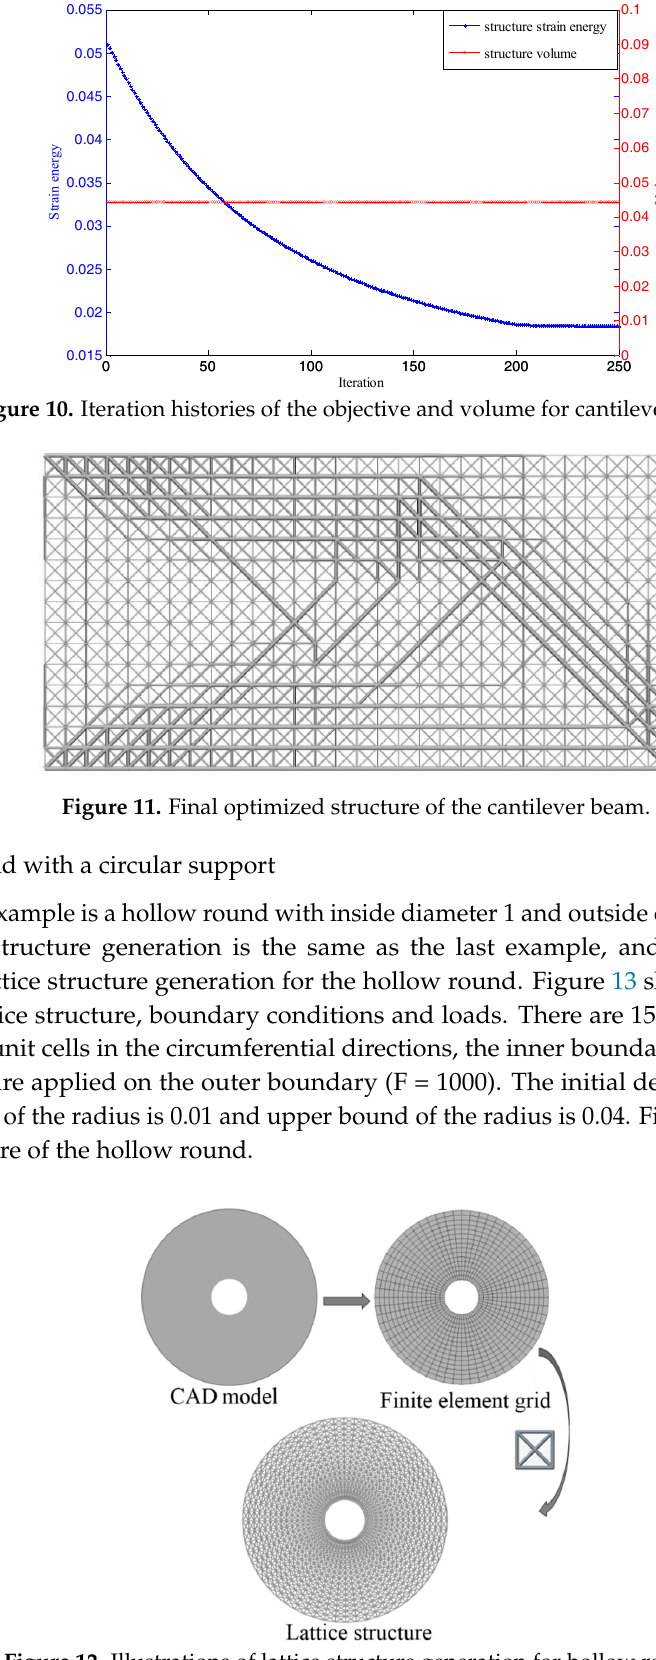
Figure 12. Illustrations of lattice structure generation for hollow round.